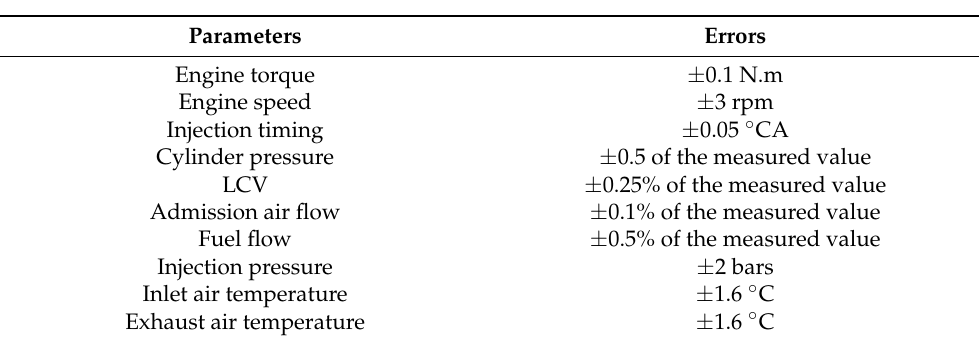
Table 3. Main characteristics of the test.